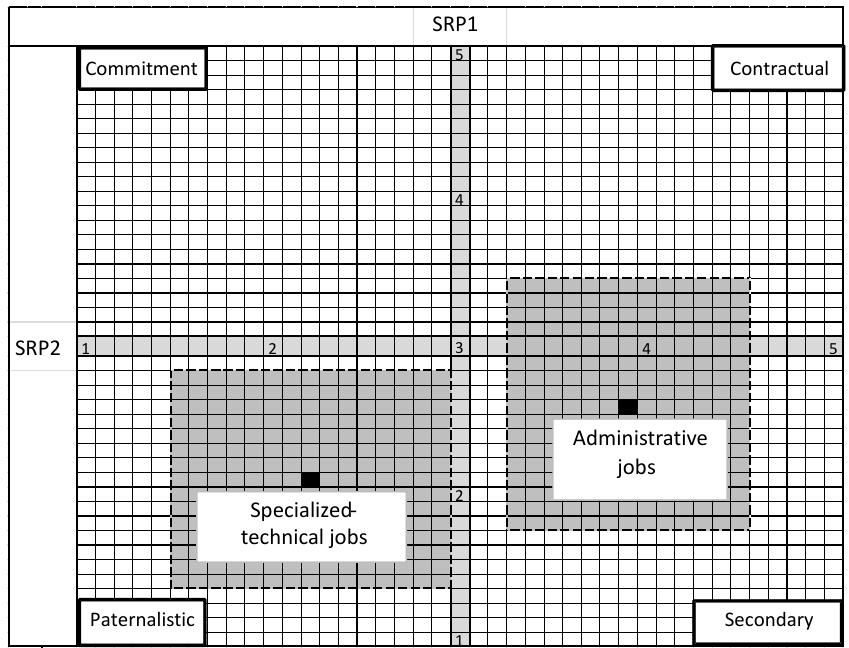
Figure 3. Determining the main SRP coordinates of administrative and specialized-technical